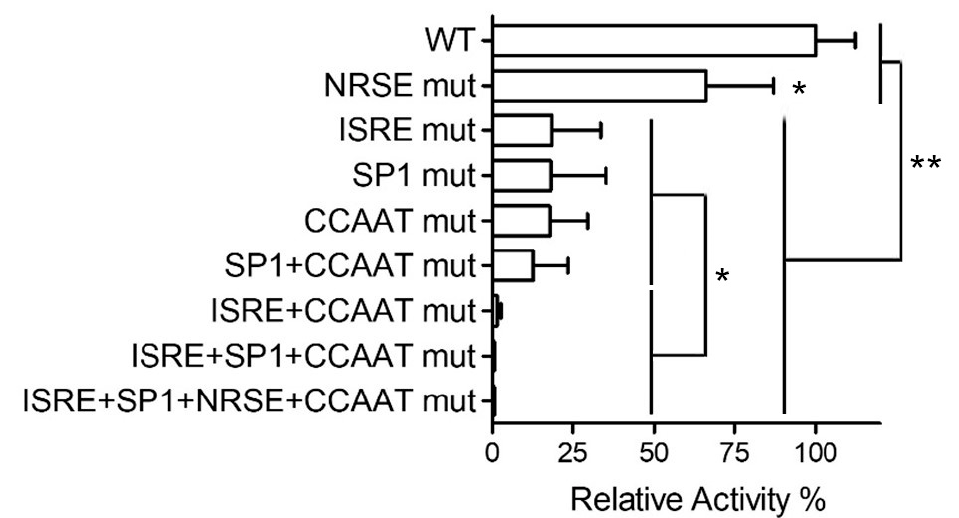
Figure 2. Mutational analysis of the predicted motifs of the human PNPT1 promoter. HeLa cells were transiently transfected with a luciferase reporter plasmid containing 396 bp (nucleotides 4692– 5087 of NG_033012.1 NCBI Reference sequence) of the PNPT1 promoter (396bp-PNPT1-prom-luc) 5 ′ upstream from the ATG (WT, wild-type), or derived plasmids containing deleterious point mu- tations of the indicated motifs. The activity of the reporter was assayed 40 h after transfection. We represent the relative activity with respect to the native version of the promoter (WT). Statistical analysis: 1 way ANOVA /Tuckey: * p < 0.05; ** p < 0.01; n = 6 (3 assays on duplicated).